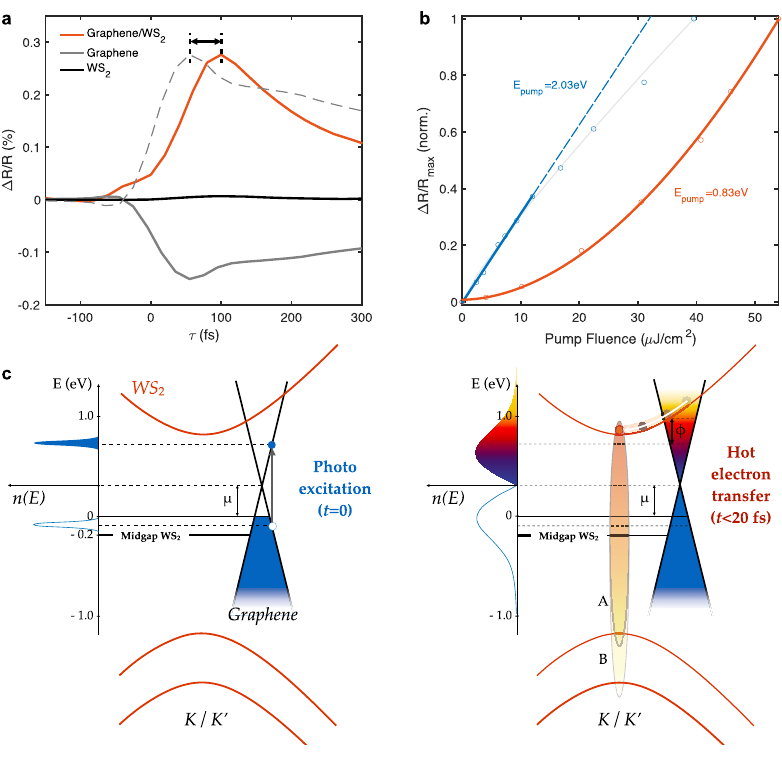
Fig. 3 Hot-electron transfer in a 1L-WS 2 /graphene HS. a Onset of the transient dynamics at the A exciton energy measured on WS 2 / graphene HS (orange), on isolated graphene (grey) and isolated WS 2 (black). The dashed grey line is the dynamics of graphene normalized to that of the HS. The pump photon energy is set to 0.88 eV and the fl uence is ~24 μ J/cm 2 . The vertical lines mark the peak of the bleaching dynamics. b Normalized fl uence dependence of the maximum of the bleaching signal ( Δ R = R max ) measured at the A exciton energy of the HS for pump excitation above (blue dots) and below (orange dots) the optical gap. The continuous lines are the fi t to the data with a power-law function. Δ R = R max grows linearly for above pump excitation (blue fi t curve α ~ 1) and starts saturating above a certain fl uence threeshold (25 μ J/cm 2 — grey fi t curve α ~ 0.9) and non-linearly for below-gap excitation (orange fi t curve — α ≈ 2). c Sketch of the energy distribution of the carrier density n ( E ) 17 , after photoexcitation of graphene at time delay t = 0, and hot-electron transfer via photothermionic process. μ is the residual doping of graphene, ϕ is the Schottky barrier, T e and T l are the electronic and the lattice temperature, respectively. The sketch of the band alignment follows the energy/momentum scale reported in Ref. 46